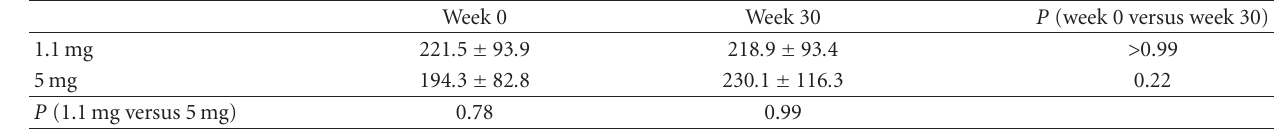
Table 6: Estimated dietary folic acid intake ( μ g/day).